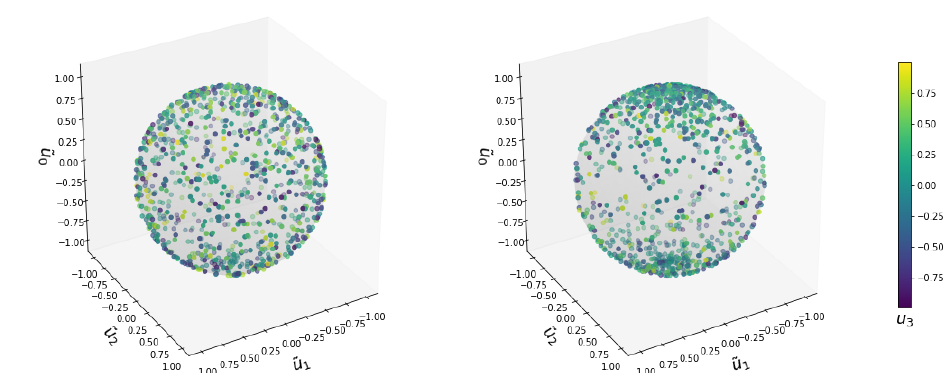
Figure 2: Visualization of 1000 samples from the dataset. Left: distribution of the initial conditions U i . Right: distribution of the labels ˜ U i 0 according to the action S [ U ] = Re Tr ( U 2 ) up to τ 1 =